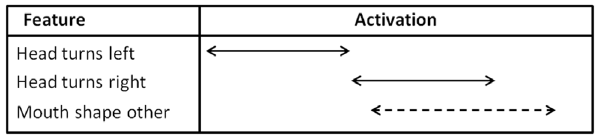
Figure 9. Computational model of positive versus negative polarity in